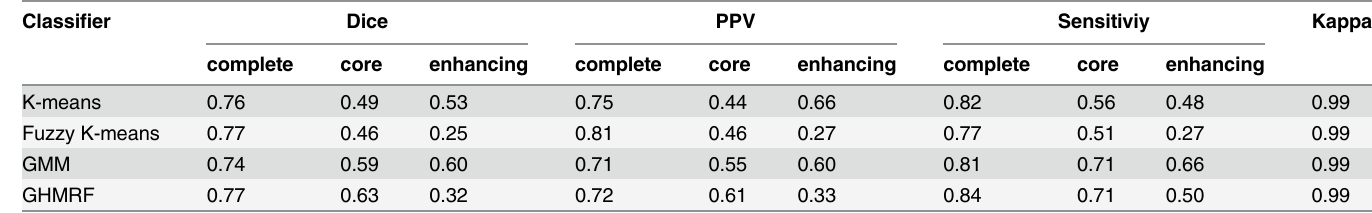
Table 2. Summary of average results obtained by the different unsupervised algorithms in combination with the proposed preprocess and post- process over the BRATS 2013 Leaderboard set. Classi fi er Dice